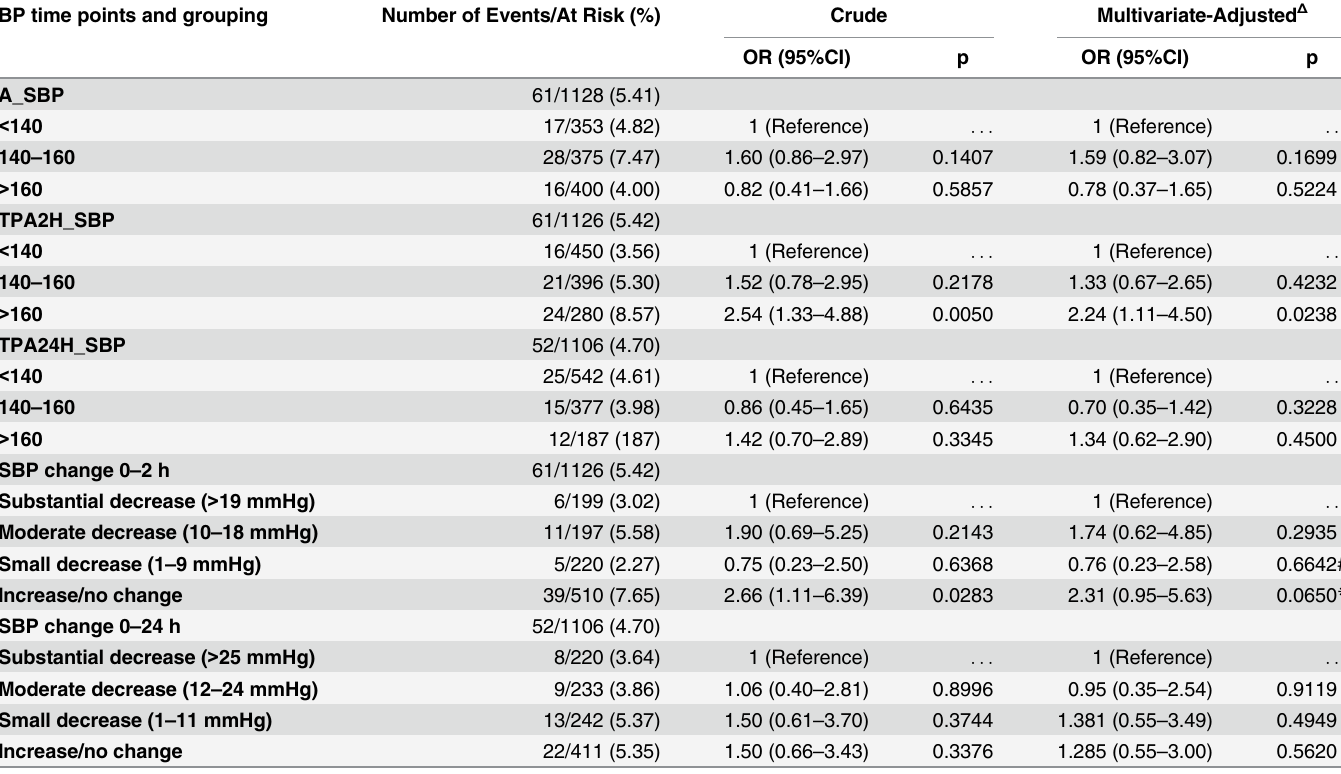
Table 4. BP grouping of different time points and